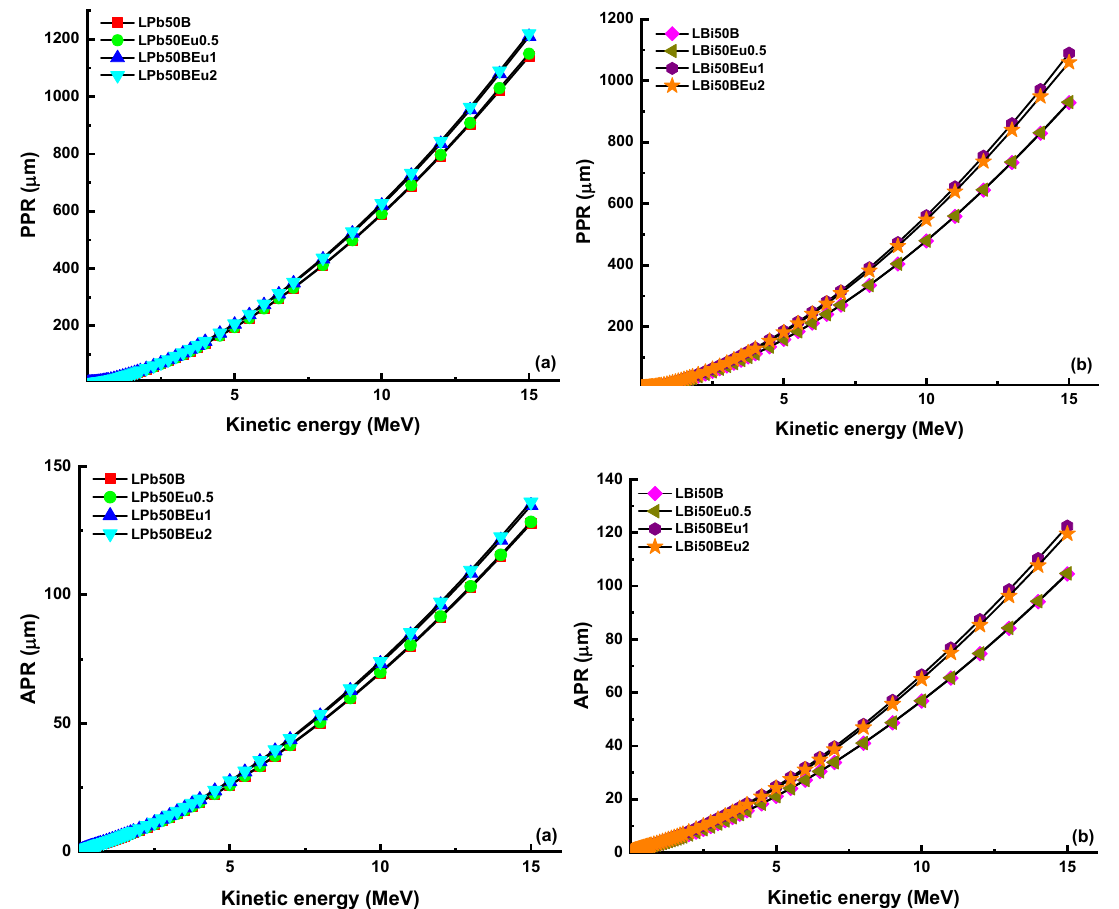
Figure 11. Proton (PPR) and alpha (APR) projected range as a function of kinetic energy for ( a ) LPb50BEu and ( b ) LBi50BEu glasses.